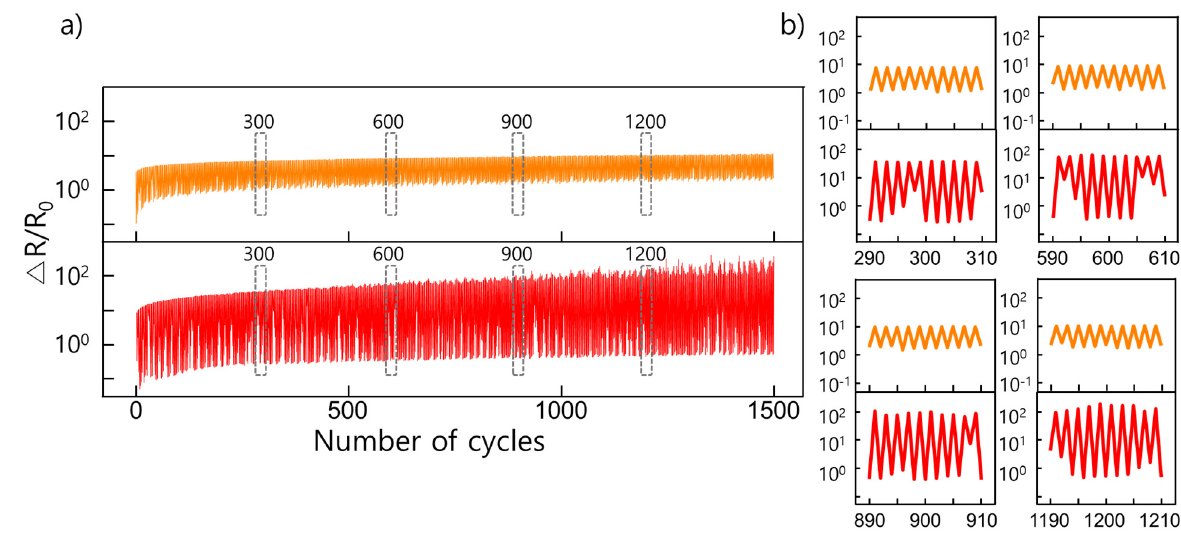
Figure 6. ( a ) Plots showing cycling strain test results over 1500 cycles with 30% strain; ( b ) Plots are magnified images of the 300th, 600th, 900th, and 1200th cycles in ( a ); the change in the resistance for each number of cycle is shown.